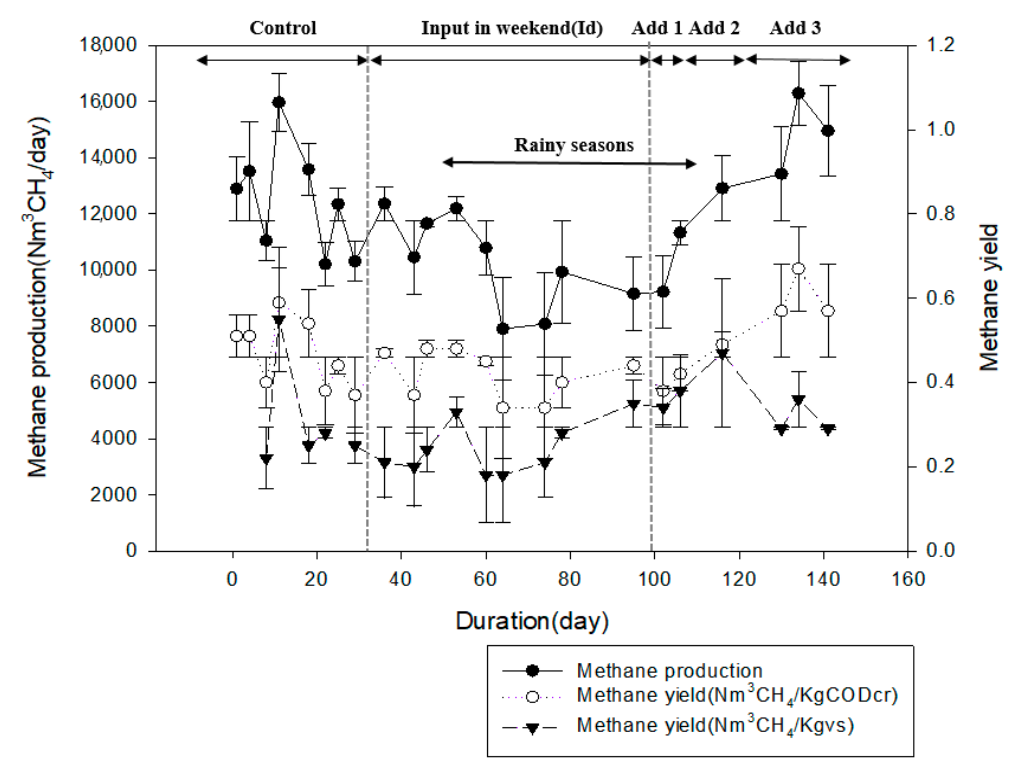
Figure 5. Plot depicting the variation in methane yield and methane production in the experimental period.